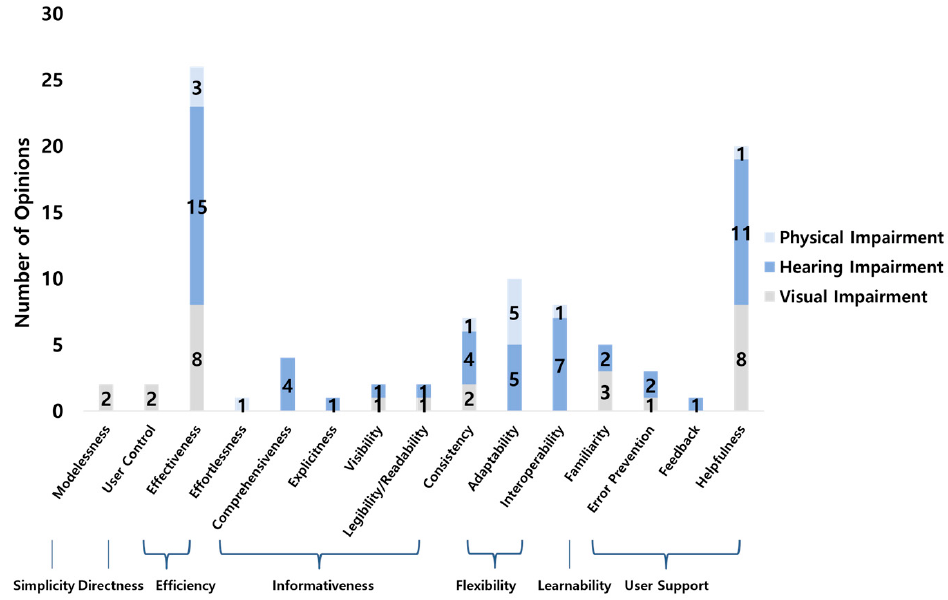
Figure 4. Number of opinions based on subcategories of usability.